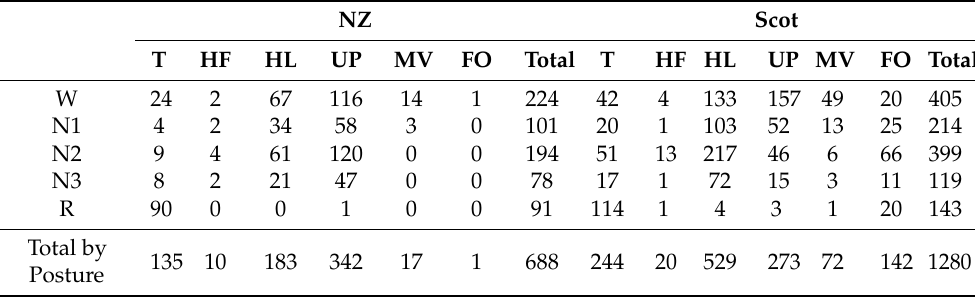
Table 2. Count of the total number of epochs of data in each posture by sleep stage (tucked (T), head resting front (HF), head low (HL), head up (UP), moving (MV) and flat out (FO)) and study country. NZ Scot T HF HL UP MV FO Total T HF HL UP MV FO Total W 24 2 67 N1 N2 9 4 61 120 0 N3 R 90 0 0